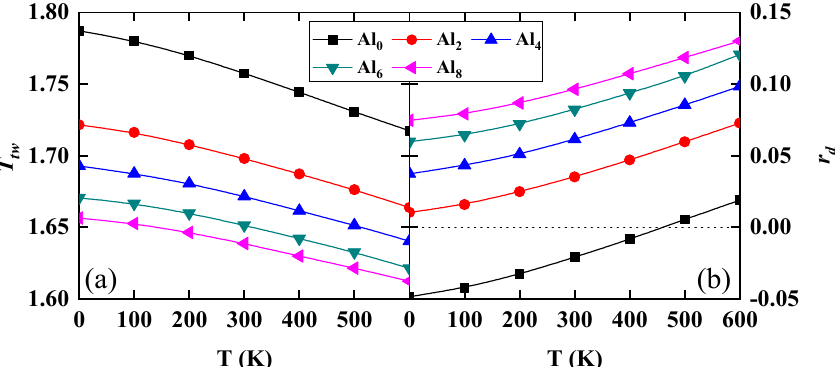
Figure 5. The effect of Al on the twinning ability of PM fcc Al y (CrMnFeCoNi) 100 − y ( y = 0, 2, 4, 6, 8) alloys as a function of temperature and composition. Shown are ( a ) T tw and ( b ) r d as a function of temperature and composition.